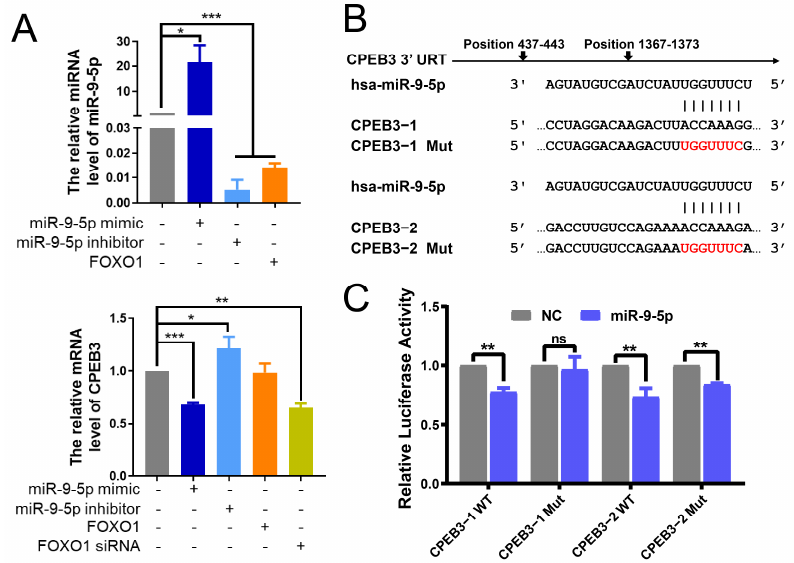
Figure 3. miR-9-5p is a negative regulator of CPEB3 . ( A ) Levels of miR-9-5p, CPEB3 were detected by qRT-PCR in miR-9-5p mimic, miR-9-5p inhibitor or FOXO1, siFOXO1 treated Bel7402 cells. Relative expression levels were calculated for treatment groups compared to the control group (normal- ized to 1), by non-parametric one-way ANOVA and Dunnett’s multiple comparison post hoc tests. Mean ± s.e.m, n = 3/group. ( B ) Schematic representation of the 3 (cid:48) UTR regions of CPEB3 ( CPEB3 transcript variant 2, NCBI: NM_001178137.1) with the putative miR-9-5p binding sites (CPEB3 − 1, position 437-443 of CPEB3 3 (cid:48) UTR; CPEB3 − 2, position 1367-1373 of CPEB3 3 (cid:48) UTR), including wild- type (CPEB3 − 1 WT, CPEB3 − 2 WT) and mutant (CPEB3 − 1 Mut − 1, CPEB3 − 2 Mut − 2). ( C ) Relative luciferase activity of the indicated CPEB3 3 (cid:48) UTR vectors in 293T cells transfected with miR-9-5p plasmids. While luciferase activity of control group was normalized to 1, Renilla luciferase activity was normalized to firefly activity and is presented as relative luciferase activity. Student’s t -test. Mean ± s.e.m., n = 3/group. * p < 0.05, ** p < 0.01, *** p < 0.001, ns: